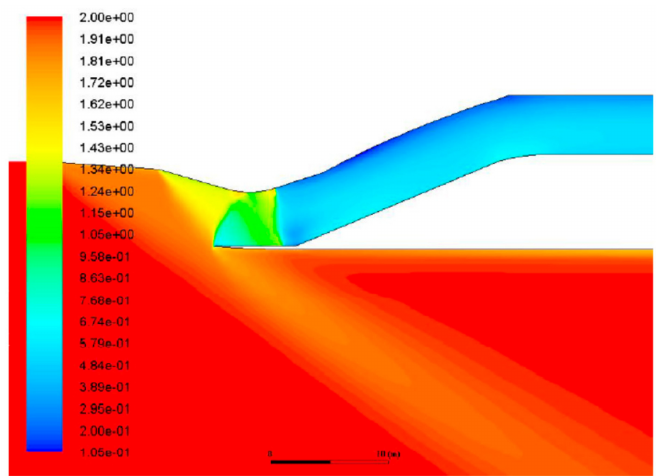
Figure 22. Over/under combined cycle engine Mach